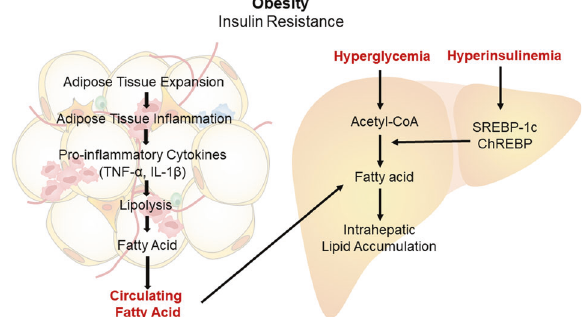
Fig. 2 Obesity-induced adipose tissue in fl ammation and NAFLD. Excess energy intake promotes adipose tissue expansion, which is closely associated with elevated pro-in fl ammatory responses in adipose tissue through the recruitment of various immune cells. In turn, these cells enhance the levels of proin fl ammatory cytokines, such as TNF- α and IL-1 β . In fl ammatory signaling stimulates adipocyte lipolysis, thereby increasing FA in fl ux into the liver. Moreover, insulin resistance in obese subjects mediates hypergly- cemia and hyperinsulinemia, which stimulates DNL by supplying substrates and inducing the activation of key lipogenic transcription factors (SREBP-1c and ChREBP). All of these factors (increased plasma FA levels, hyperglycemia, and hyperinsulinemia) exacerbate lipid accumulation in the